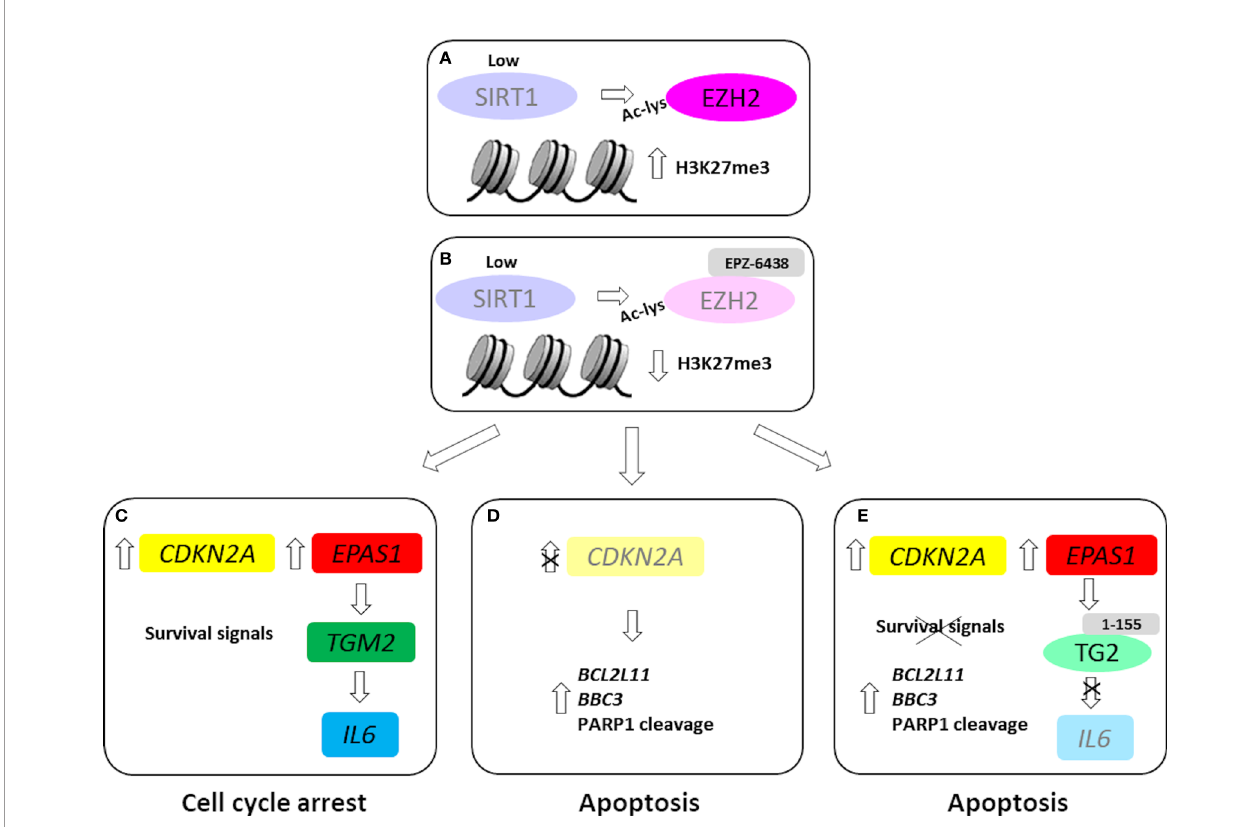
FIGURE 6 | EZH2 inhibition in wild-type and CDKN2A silenced MPM MCS. In our MPM model, SIRT1 inhibition/silencing induced EZH2 acetylation and stability (A) . EZH2 inhibition, by EPZ-6438 treatment (B) , induced the expression CDKN2A , causing cell growth arrest. Furthermore, EPZ-6438 treatment upregulated EPAS1 and downstream TGM2 and IL6 (C) . EPZ-6438 treatment induced apoptosis in CDKN2A silenced MPM MCS (D) . Combined treatment with EPZ-6438 and 1-155, a selective TG2 inhibitor, abolished IL6 induction and led to apoptotic death (E) . Light colors were used to indicate low or null levels of gene expression or protein